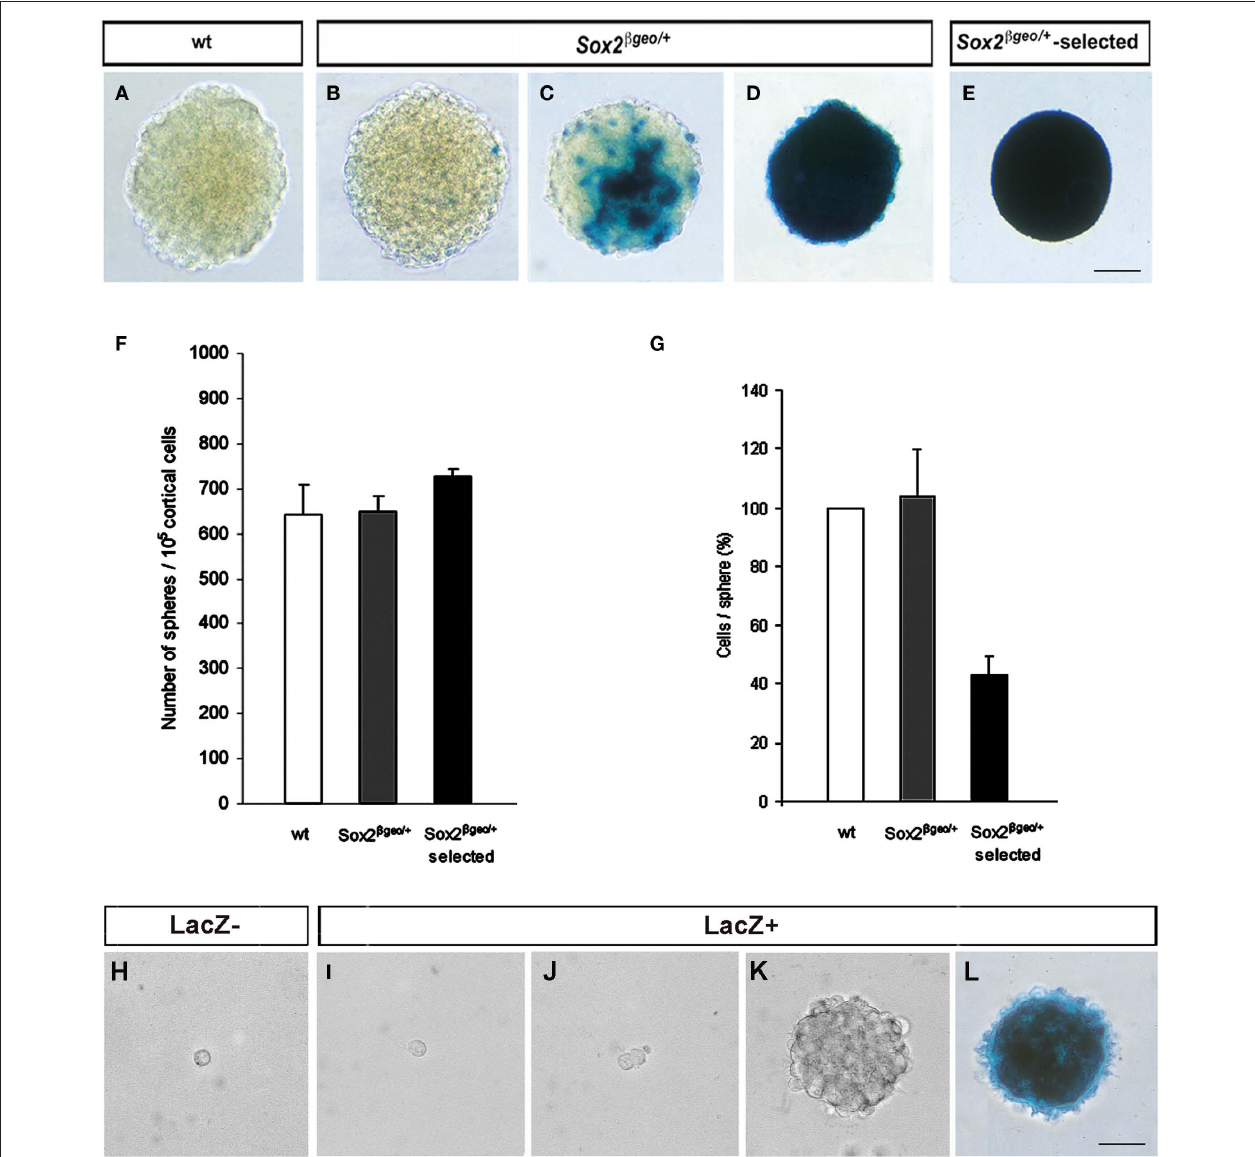
the size of Sox2 β geo/ + -selected cell pool was significantly smaller (g) . The data are presented as the mean ± SD (H, i) . Sox2 β geo/ + neurospheres were dissociated and fractionated into Sox2 β geo/ + -expressing [ (i) , LacZ + ] and non-expressing cells [ (H) , LacZ − ] using FACS. Each cell population was cultured at clonal density (10 4 cells/ ml) and allowed to proliferate (J) without selective pressure. Only Sox2 β geo/ + - expressing cells generated neurospheres (K) expressing variable levels of β -galactosidase activity [ (L) ; scale bar =